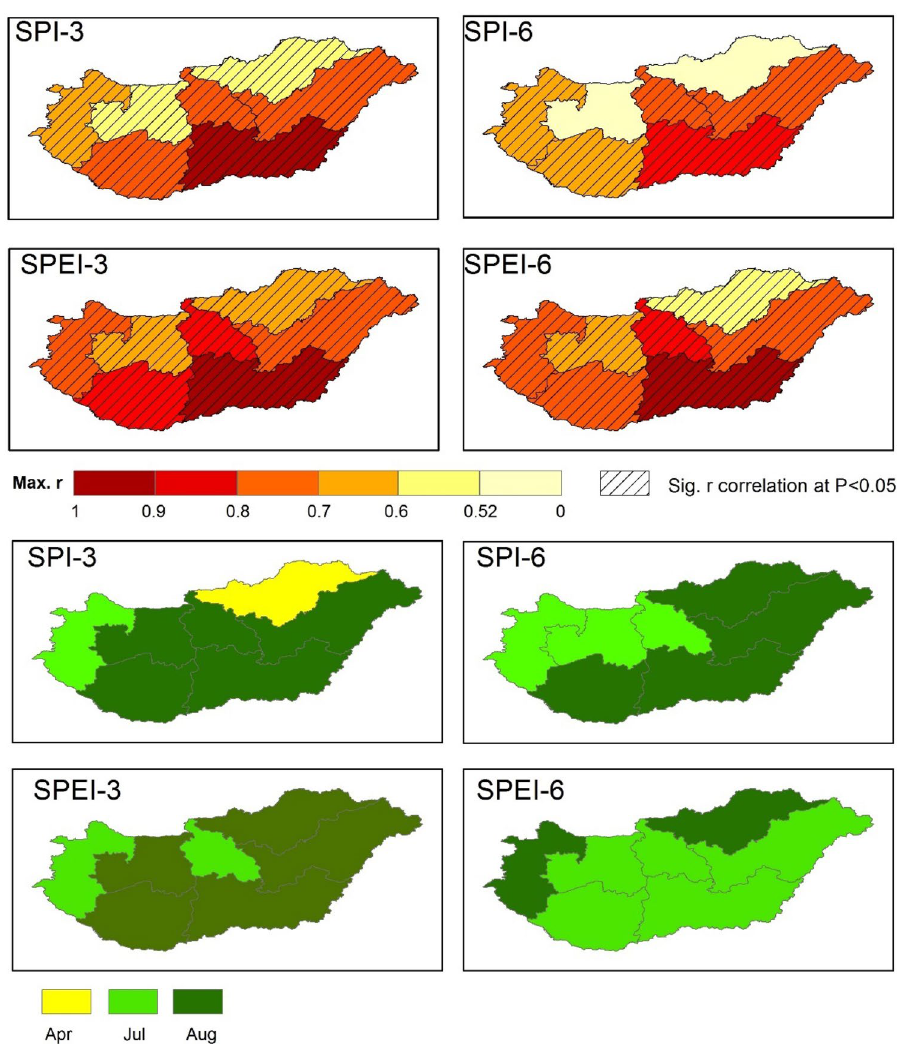
Figure 11. Spatial distribution of maximum correlation between drought indices (SPI-3, SPEI-3, SPI-6, SPEI-6) and SYRS for maize across Hungary (2000–2010) (upper figures), the corresponding month where the maximum correlation is occurred during the growing cycle (lower figures) (maps were generated using ArcGIS 10.5 (https:// www. esri. com/ en- us/ about/ about- esri/ overv